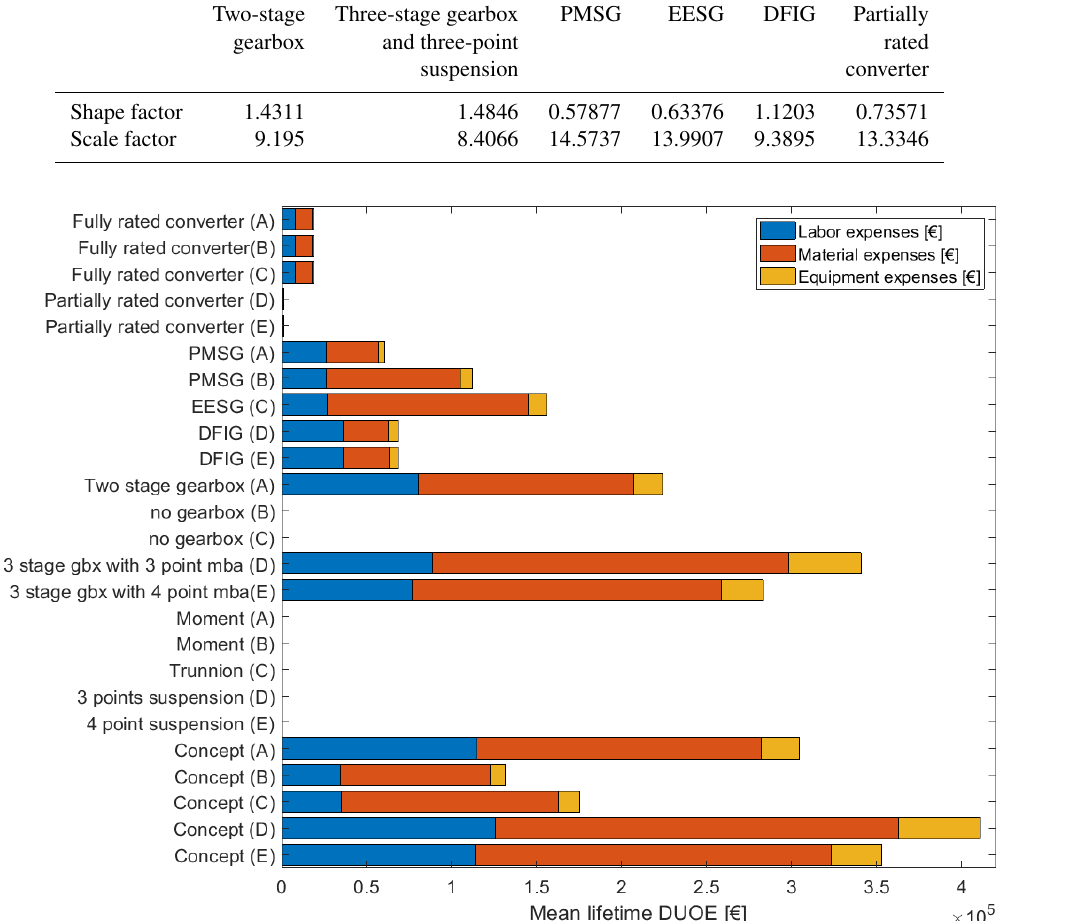
Figure 5. Drivetrain concept comparison based on 1000000 iterations for a 3MW and 120m rotor diameter